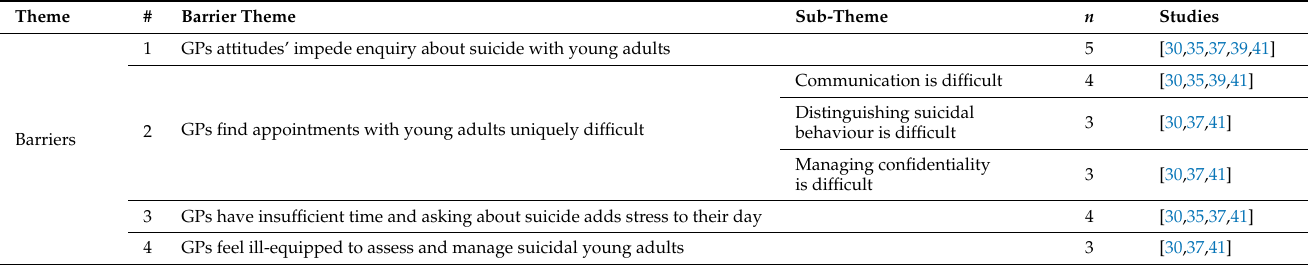
Table 2. GPs: Key barrier and facilitator themes (n=